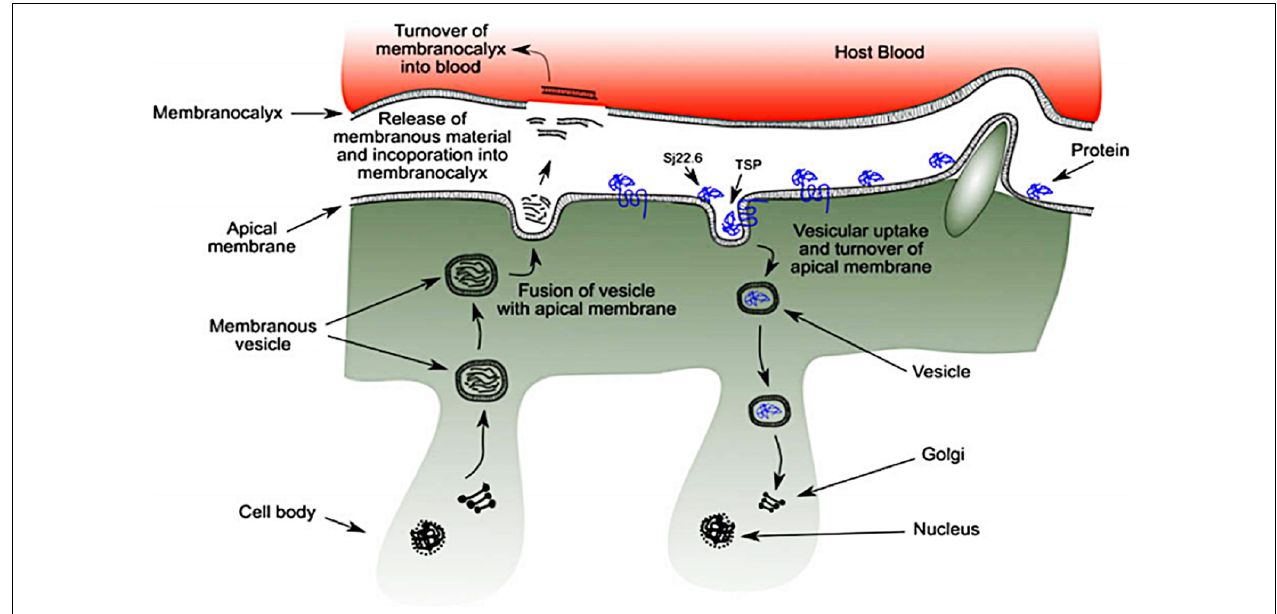
FIGURE 3 | Schematic diagram of schistosome tegument structure with several organelles and the position of targeted proteins (as seen in blue) (reprinted with permission from Mulvenna et al.,